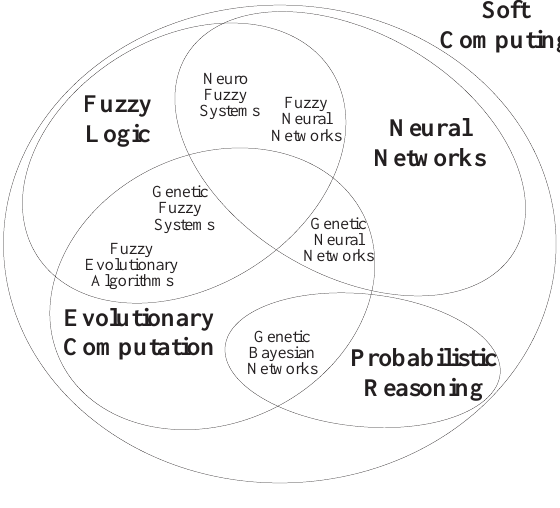
Fig. 2. A graphical view of Hybridization according to Cord´on et al. 4